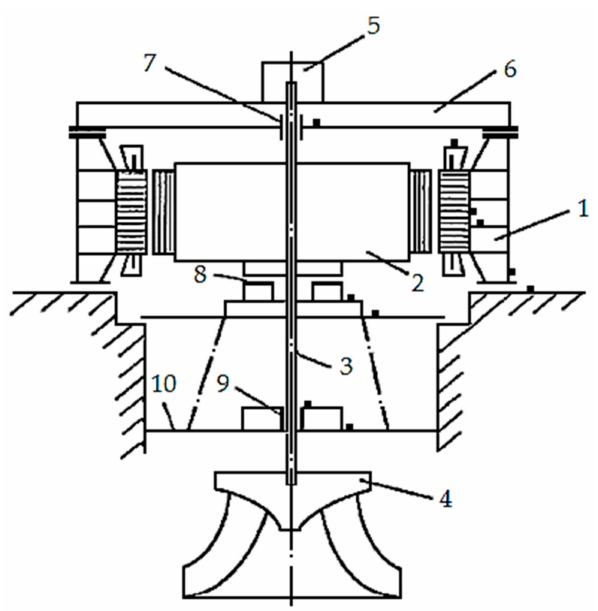
Figure 2. Hydroturbine unit (HTU) with typical arrangement of measuring sensors: 1, generator stator; 2, rotor; 3, hydraulic unit shaft; 4, hydraulic turbine; 5, exciter; 6, upper crosspiece; 7, upper guide bearing; 8, thrust bearing; 9, turbine bearing; 10, turbine cover; (cid:4) , installations of measuring